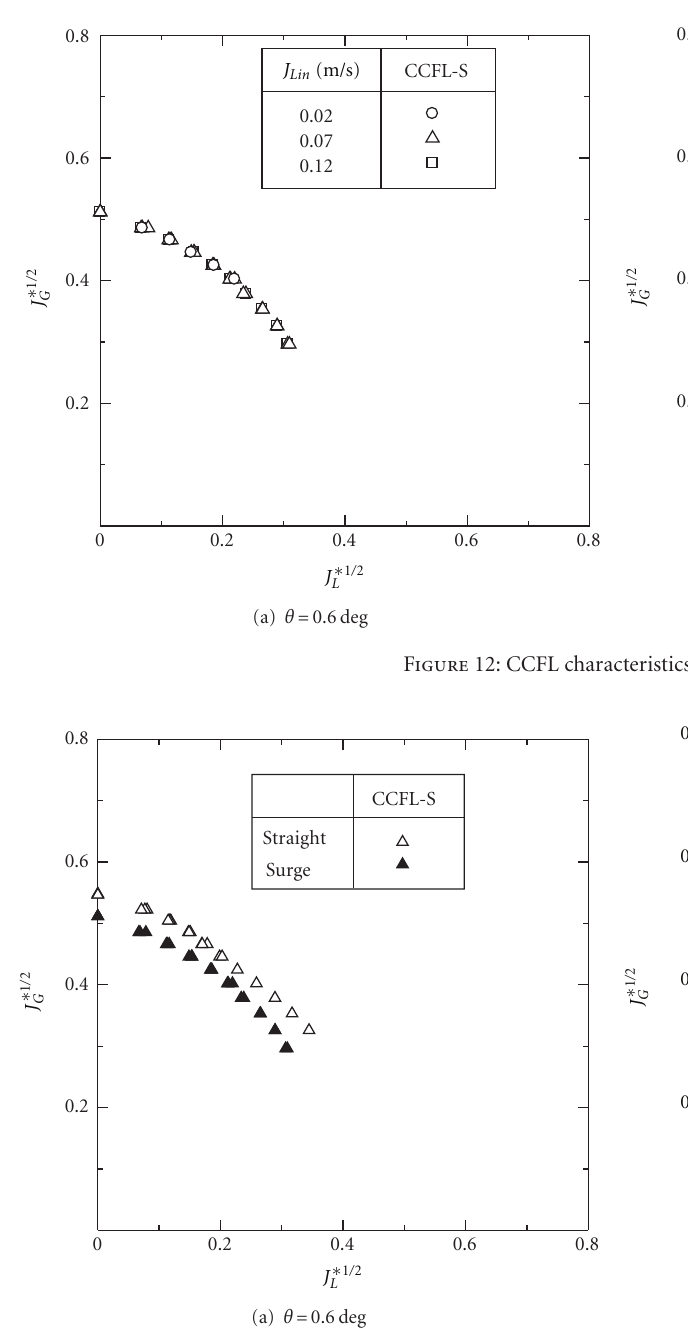
Figure 13: E ff ect of elbows on CCFL